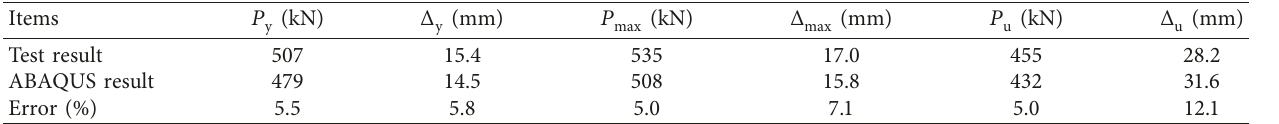
Table 7: Comparison of the finite element analysis and experimental results of specimen C-JC.